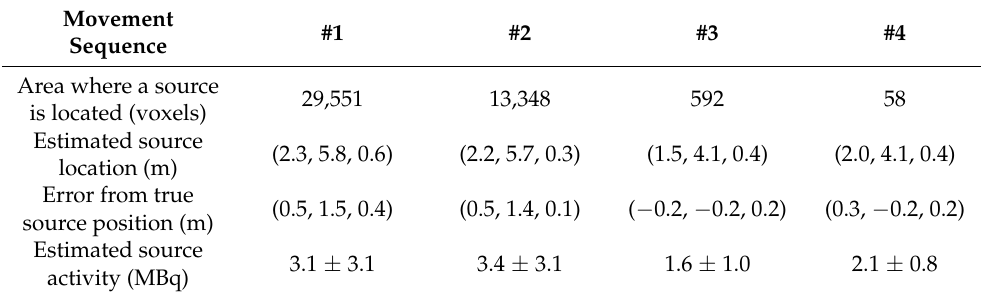
Figure 8. Photograph of the experimental setup. Table 6. Summary of the source intensities and locations estimated in the